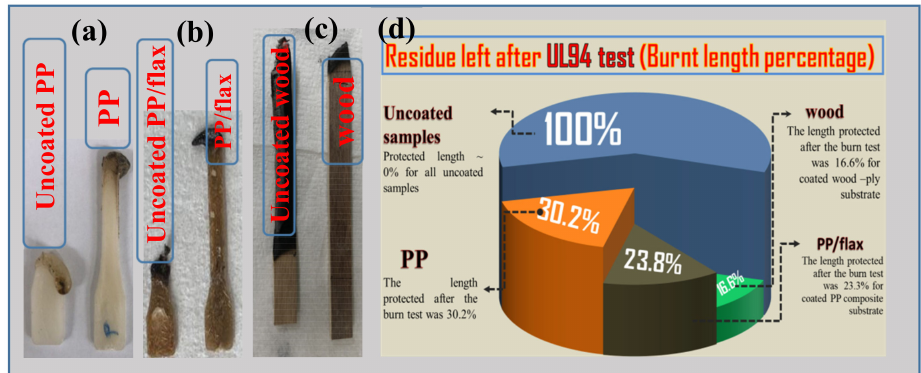
Figure 8. ( a – c ) Flame test specimens and ( d ) % of the residue left after flame